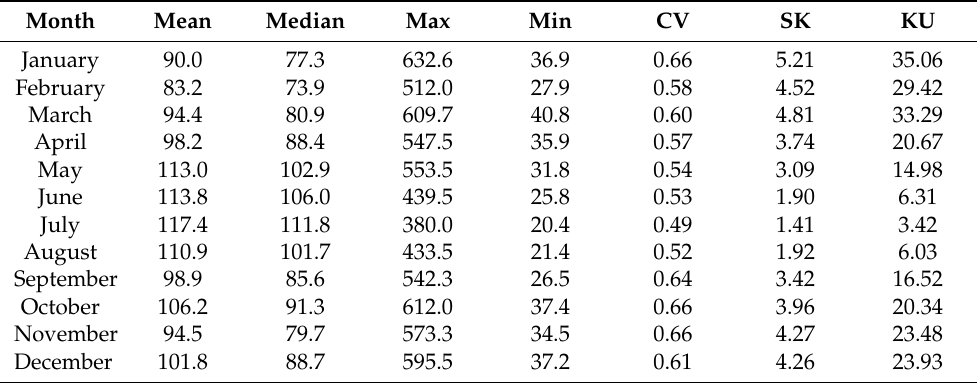
Table 1. Descriptive statistics of the monthly precipitation observation for the 294 rainfall